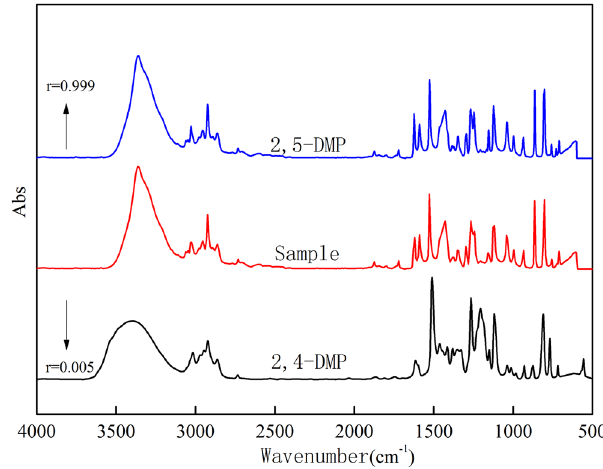
Figure 7. IR spectra of 2, 5-DMP, 2, 4-DMP and sample obtained through HPLC-FTIR in raw water.